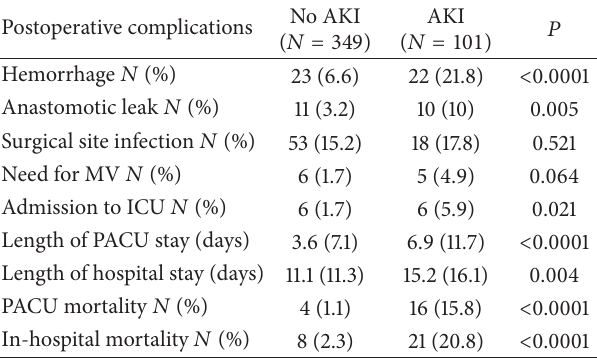
Table 4: Postoperative complications, length of stay, and